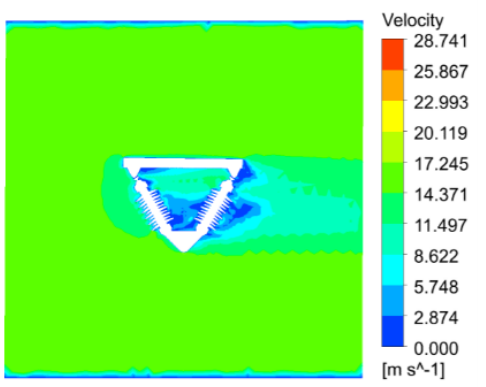
Figure 14. Cloud map of the plane velocity distribution under the wind speed of 15 m/s.